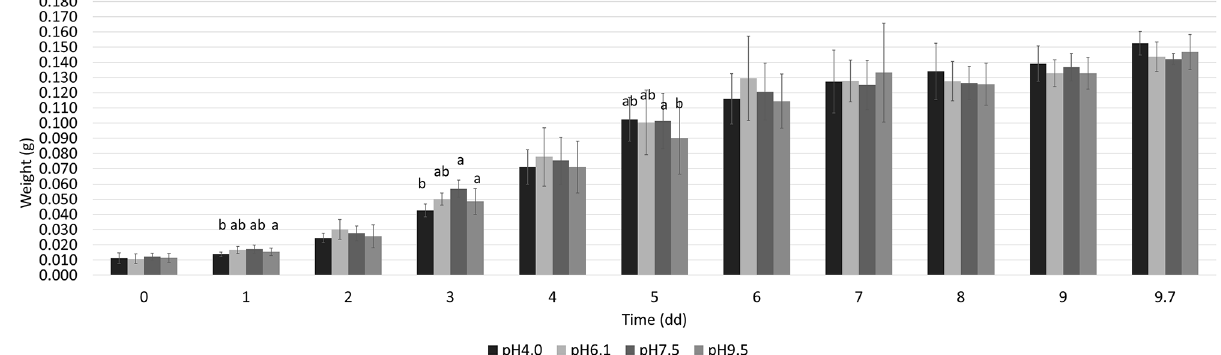
Fig 1. The average weight (means ± standard deviation (SD)) of BSF larvae reared on diets with different pH levels (pH4.0; pH6.1; pH 7.5; pH9.5) over time. Bars topped with different letters indicate a significant difference ( P (cid:20) 0.05) as inferred by post-hoc pairwise comparisons.